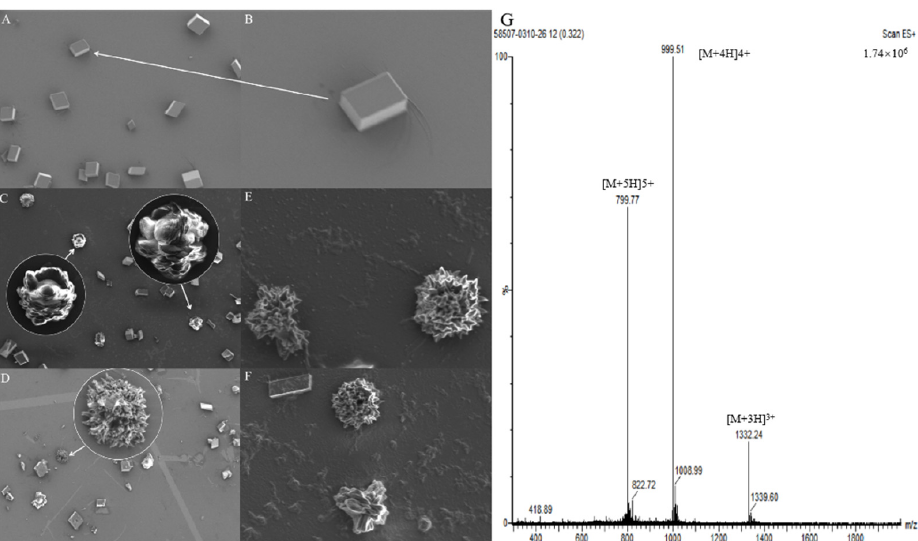
Figure 8. Crystal morphology detection by SEM and MS analysis of the cysrichin polypeptide. Note: ( A ) Control group, ( B ) Magnified view of the crystal indicated by the arrow; ( C – F ) Effects of cysrichin on crystallization; the circled areas are the magnified view of the arrow. ( C , E , F ) When a total of 90 µg/mL cysrichin was added to the system; ( D ) when 60 µg/mL cysrichin was added to the system. ( G ) Mass spectrogram of the synthetic cysrichin peptide.